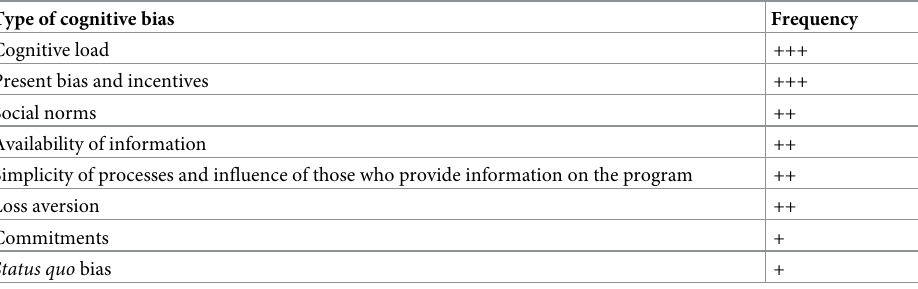
Simplicity of processes and influence of those who provide information on the